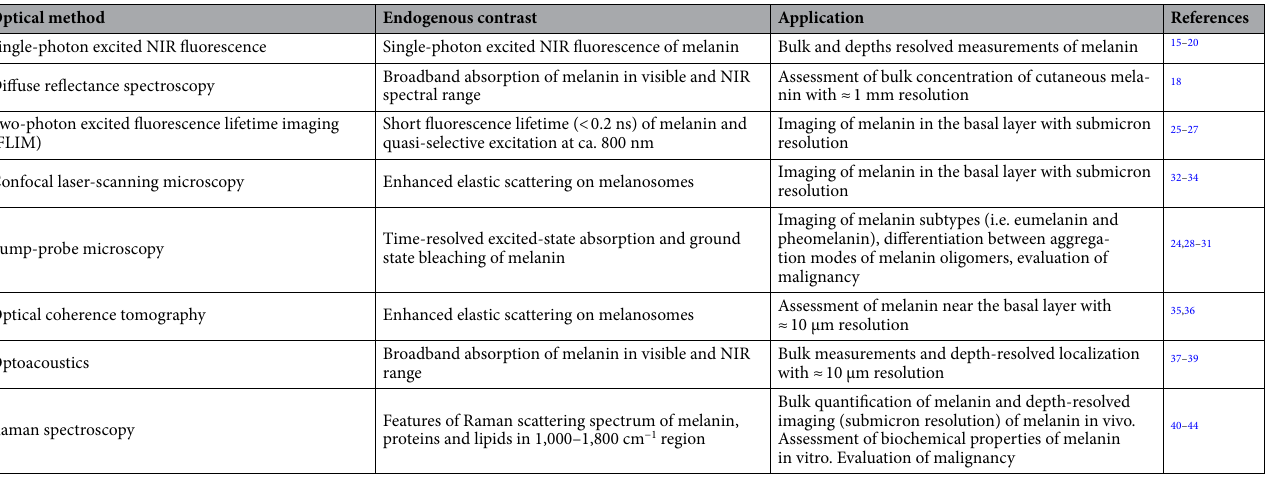
Table 1. Summary on non-invasive optical methods used for quantification, imaging and structural characterization of melanin in the